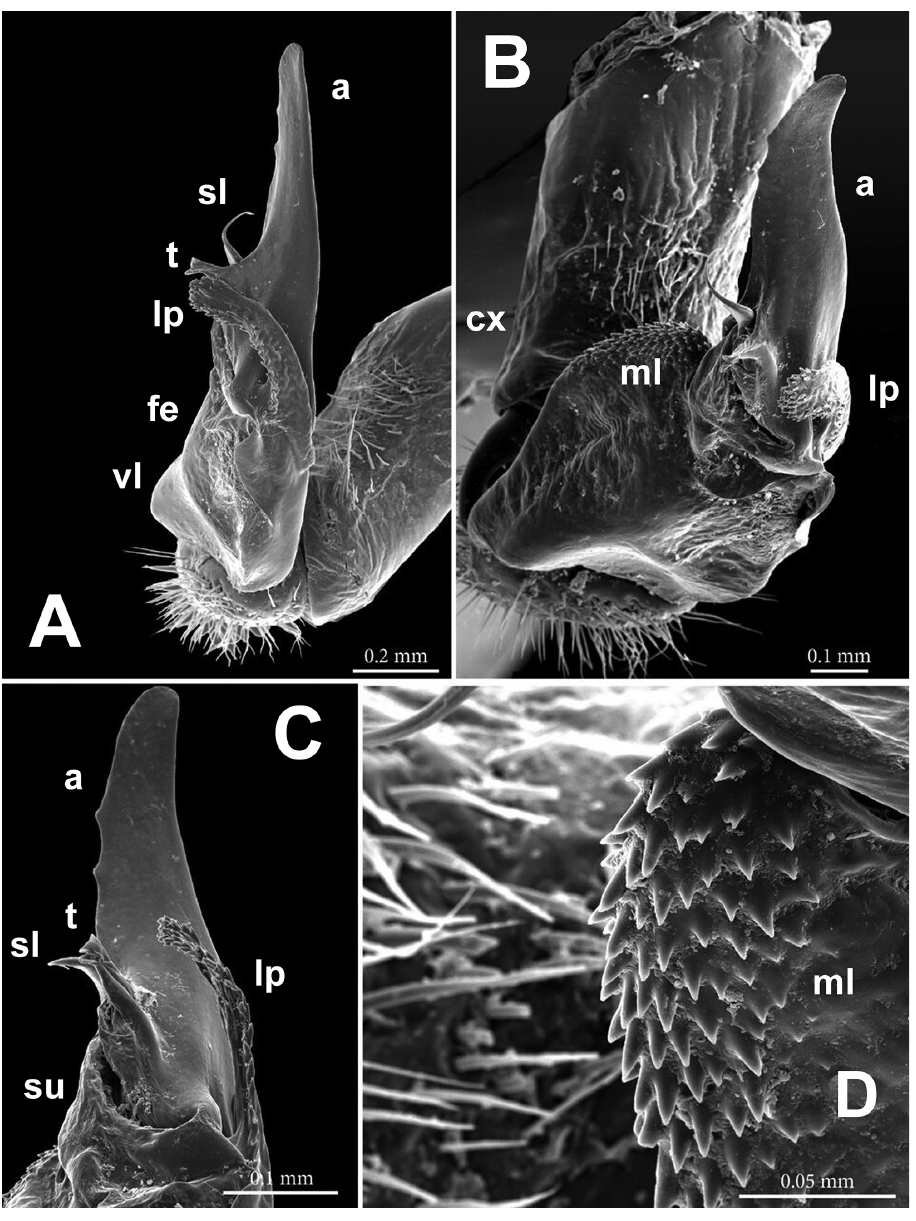
Figure 3. Annamina xanthoptera Attems, 1937, ♂ paralectotype (NHMW), SEM micrographs of entire left gonopod ( A, B ), ventrolateral and subventral views, respectively, and of its distal parts ( C, D ), sub- ventrolateral views (cx = coxite; fe = femorite, vl = ventral lobe; ml = mesal lobe; su = postfemoral sulcus; lp = lateral process; a = apical process; sl = solenomere; t = solenophore